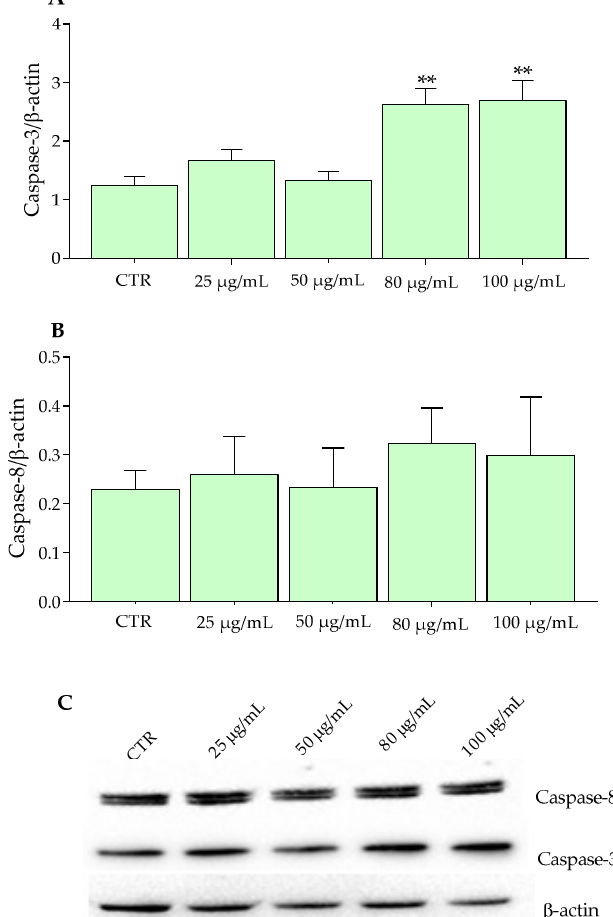
Figure 5. Western blotting analysis of Caspase proteins in SW480 cells exposed to Aglianico GP gastrointestinal digested extract at increasing concentrations for 24 h. ( A ) Caspase-3 proteins; ( B ) Caspase-8 proteins; ( C ) Relative blots. All data represent the result of three different experiments (means ± SD). p -value was determined by ANOVA with Dunnett’s test. ** p < 0.001.